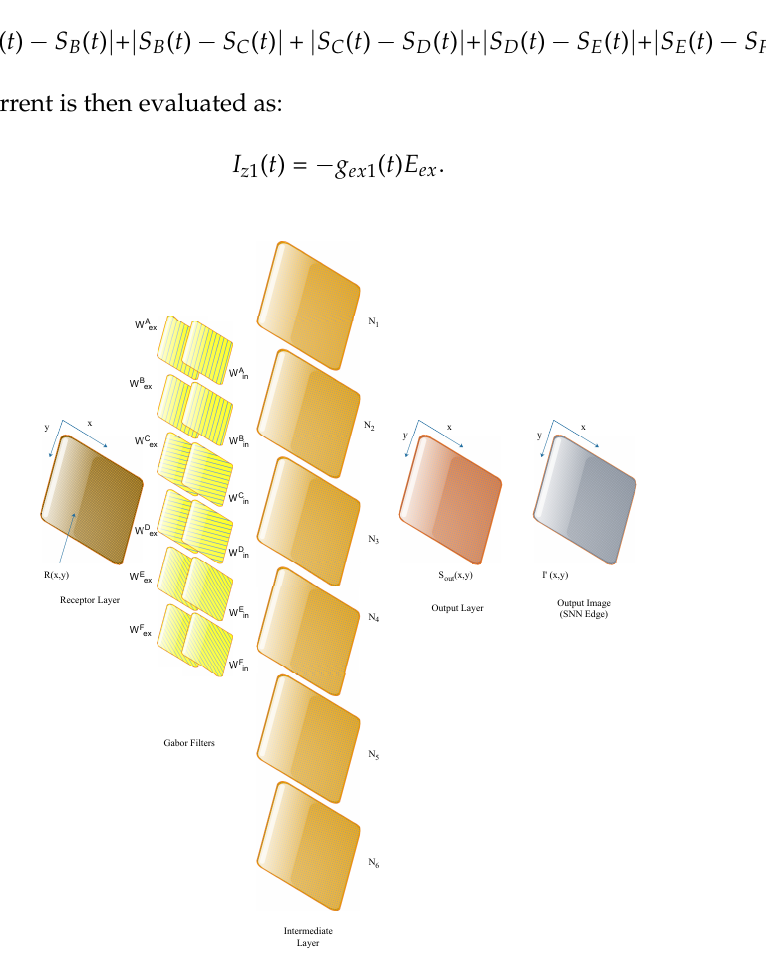
Figure 2. Spiking Neural Network Architecture showing the neuron spike processing layers of the edge